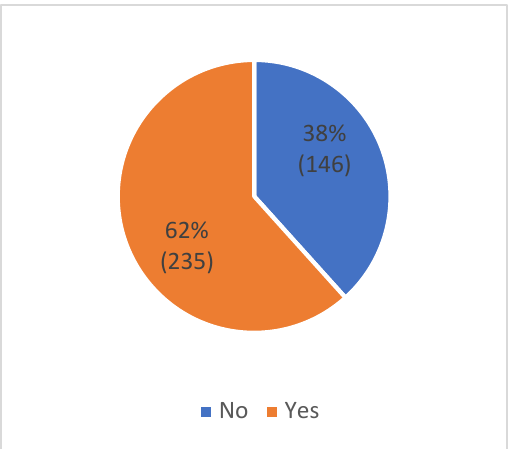
Figure 2. Participants who reported missing one or more appointments in the previous years.